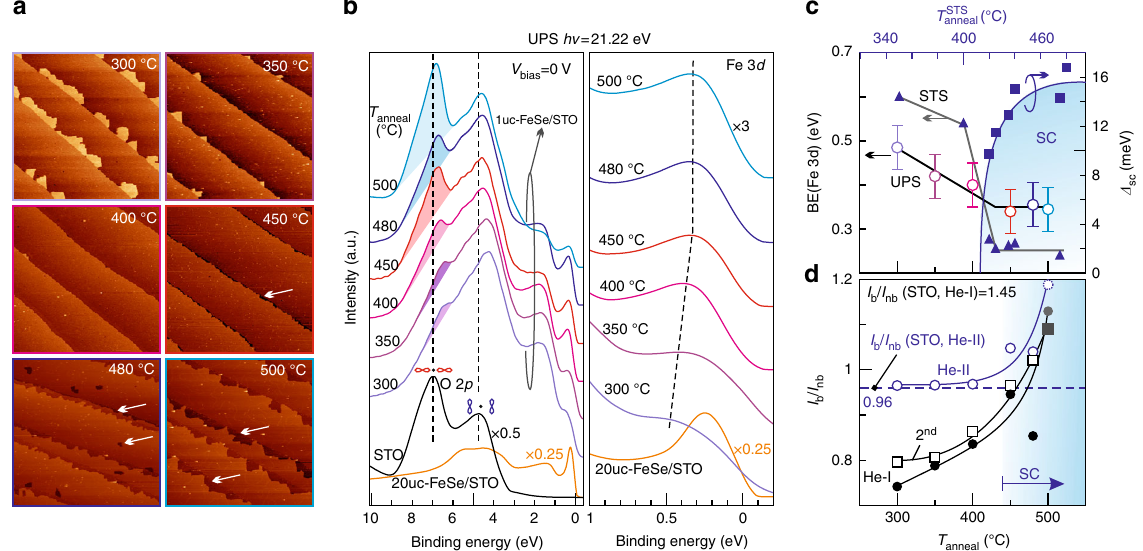
Fig. 1 STM topography and valence band spectra of 1uc-FeSe/STO at different annealing stages. a STM images (500 × 500 nm 2 ) of 1uc-FeSe/STO annealed consecutively at 300, 350, 400, 450, 480, and 500 °C. Arrows indicate regions where the STO substrate is exposed. b Valence spectra of O 2 p -and Fe 3 d -derived features obtained by using the He-I light at 21.22 eV. All the spectra for FeSe/STO are normalized to the integrated intensity of O 2 p peaks. Curves are vertically offset for clarity. The dashes are a visual guide, marking the O 2 p features of STO. The fi gure-of-eight patterns represent the O 2 p orbitals pointing to (bonding) or avoiding (non-bonding) the Ti atom ( black dot ). Shaded regions highlight the Ti – O bonding related peak. c Correlation between annealing and superconductivity unveiled by the shift of the Fe 3 d peak observed both in UPS and low-temperature STS. The STS data were obtained from a separate system with the sample cooled to 4.6 K. The superconducting gap is de fi ned as half of the distance between the two coherent peaks/kinks (Supplementary Fig. 2). The annealing temperatures for this system are marked on the top abscissa. Error bars were from the energy resolution of the measurement. d Intensity ratio between the bonding and non-bonding peaks as a function of annealing temperature probed by He-I (21.22 eV) ( solid circles and empty squares ) and He-II (40.81 eV) ( empty circles ) light sources. The squares represent data taken from a second sample following the same annealing process, which are offset by 0.1 for